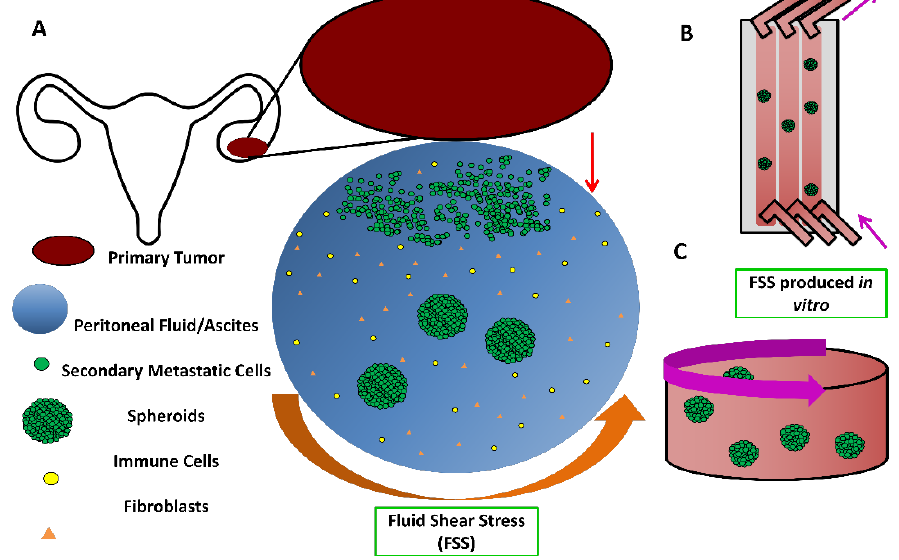
Figure 1. Overview of ovarian cancer metastasis and microenvironment. ( A ) Cells are shed from the ovarian cancer primary tumor into the peritoneal cavity. Following exposure to the fluidic currents and growth factors the cells aggregate into spheroids. This fluid flow can be mimicked in vitro either using microfluidic channels (B) or rotary movement of wells (C).